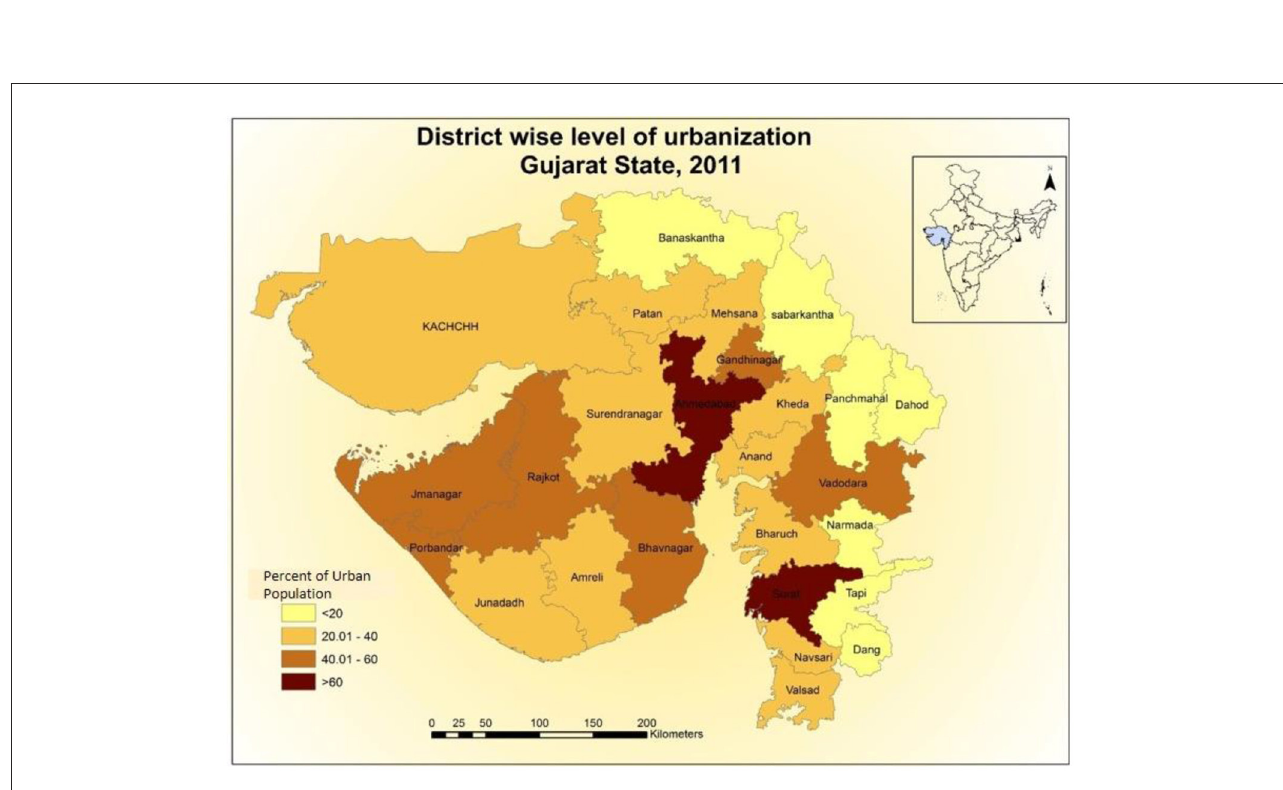
FIGURE3 District-wise level of urbanization, Gujarat-2011. Source: Prepared by the Authors,